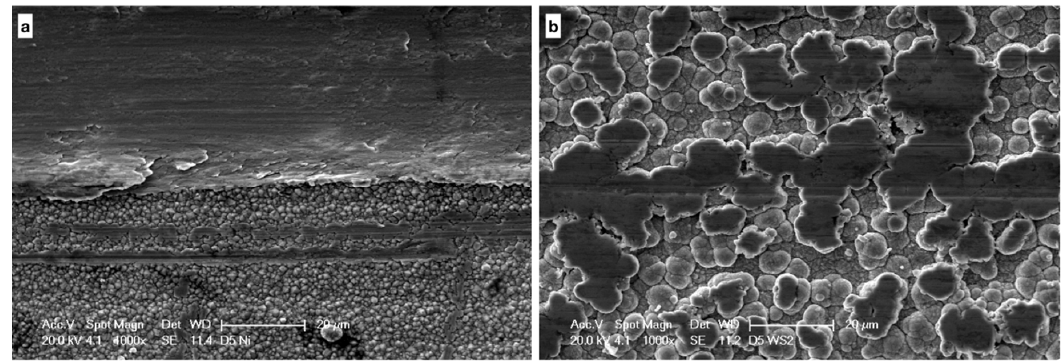
Figure 7. Morphology of damage of the coating material. ( a ) 400× magnification, ( b ) 1000× magnification.